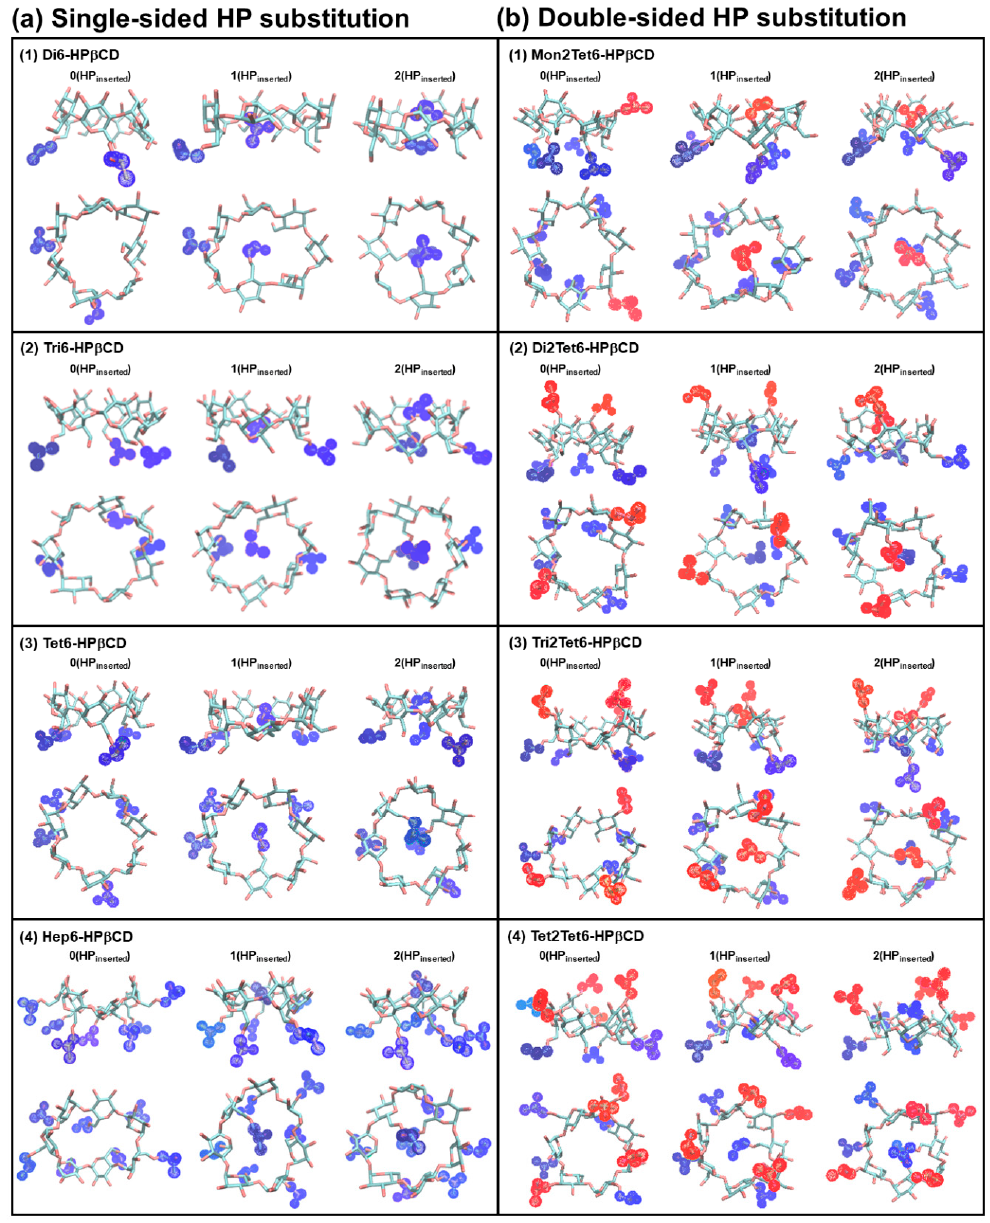
Figure 9. Example snapshots of different numbers of HP occupied in the CD cavity (criteria: d 4(i) [C g( β CD) –C g(HP(i)) ] < 3 Å) for all HP β CDs at 300